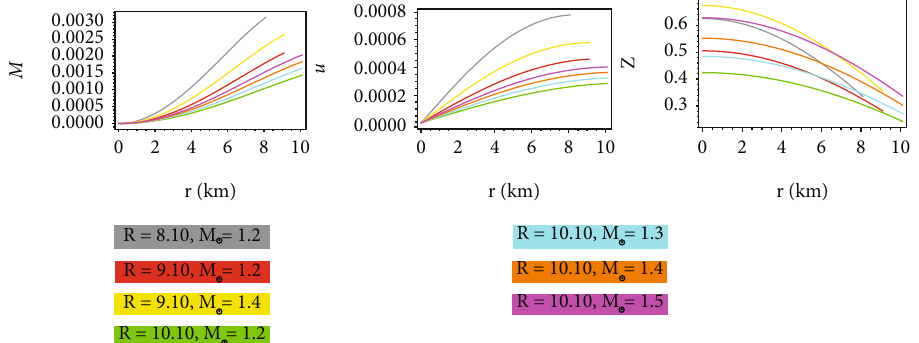
2 − v 2 for f ð R Þ gravity model. t r